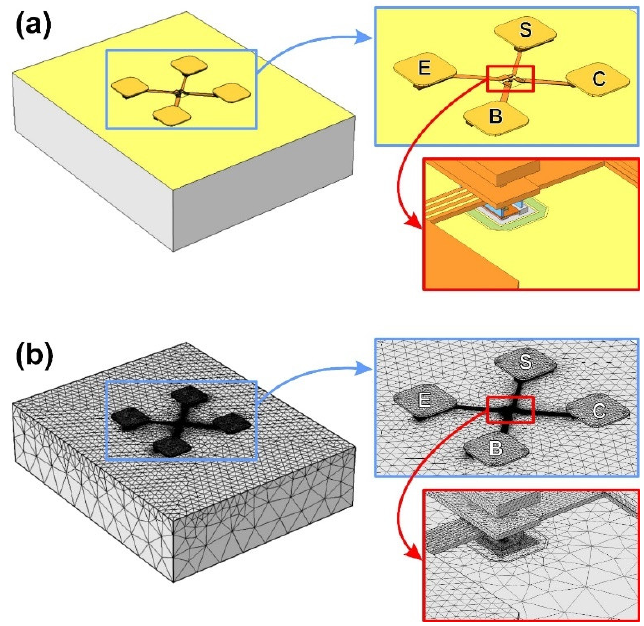
Figure 3. COMSOL environment: ( a ) geometry of the Si/SiGe HBT under test and ( b ) related mesh.